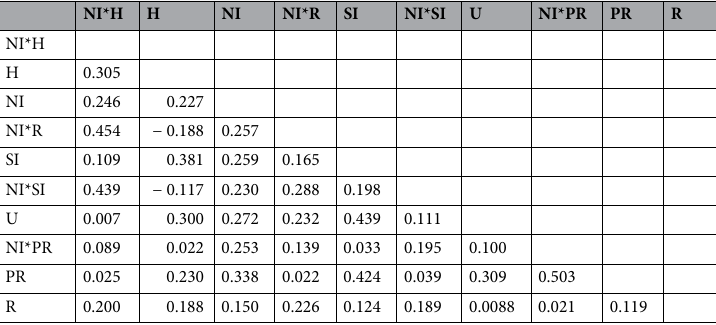
Table 4. Discriminant validity (Heterotrait–Monotrait ratio). R perceived risk, SI social influence, PR perceived fairness, H habit, NI national identity, U usage.